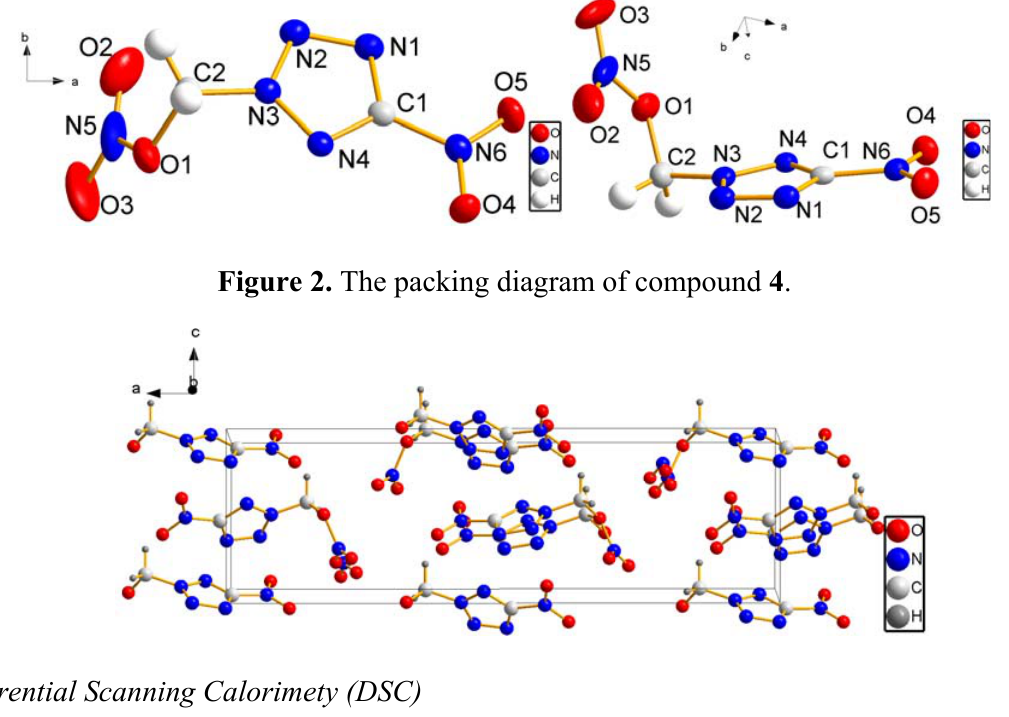
Figure 1. Molecular structure of 4 at 50% probability ellipsoids.